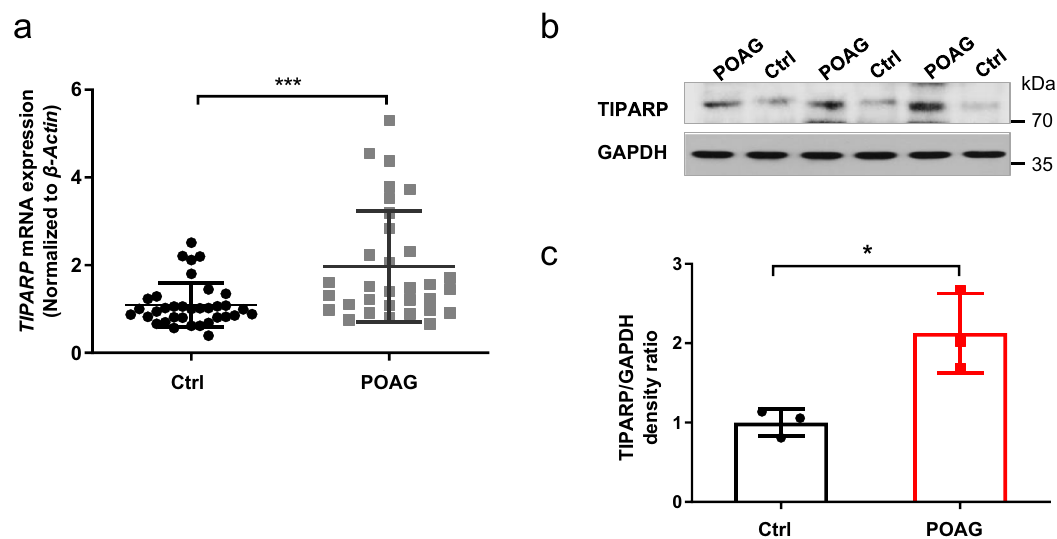
Fig. 2 TIPARP expression in patients with POAG. a The expression of TIPARP was signi fi cantly higher in the blood samples of the patients with POAG ( n = 32) than in the controls ( n = 35) (1.80-fold, P < 0.001, Mann ‒ Whitney U test). b , c Western blot analysis showed that the TIPARP protein expression was signi fi cantly higher in the surgical trabecular meshwork from the patients with POAG than in the human donor eyes (2.13-fold, n = 3, P = 0.02, t -test). Data are presented as the means ± standard deviations. * P < 0.05, *** P < 0.001.